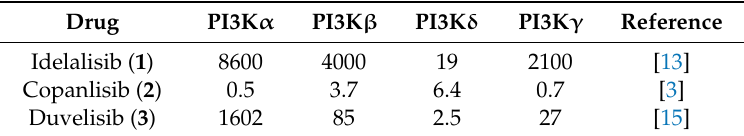
Table 1. Inhibitory profile of idelalisib ( 1 ), copanlisib ( 2 ), and duvelisib ( 3 ) against each PI3K isoform (IC 50 values in nM).